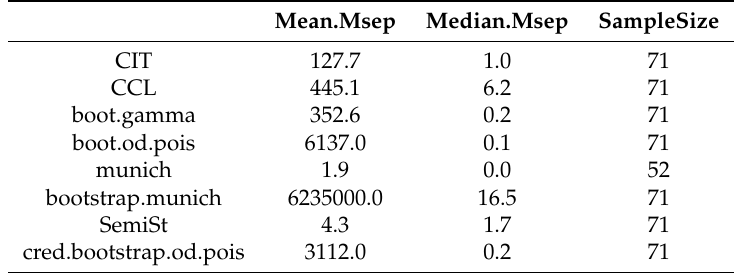
Table 14. Mean square error of prediction from the commercial auto data.